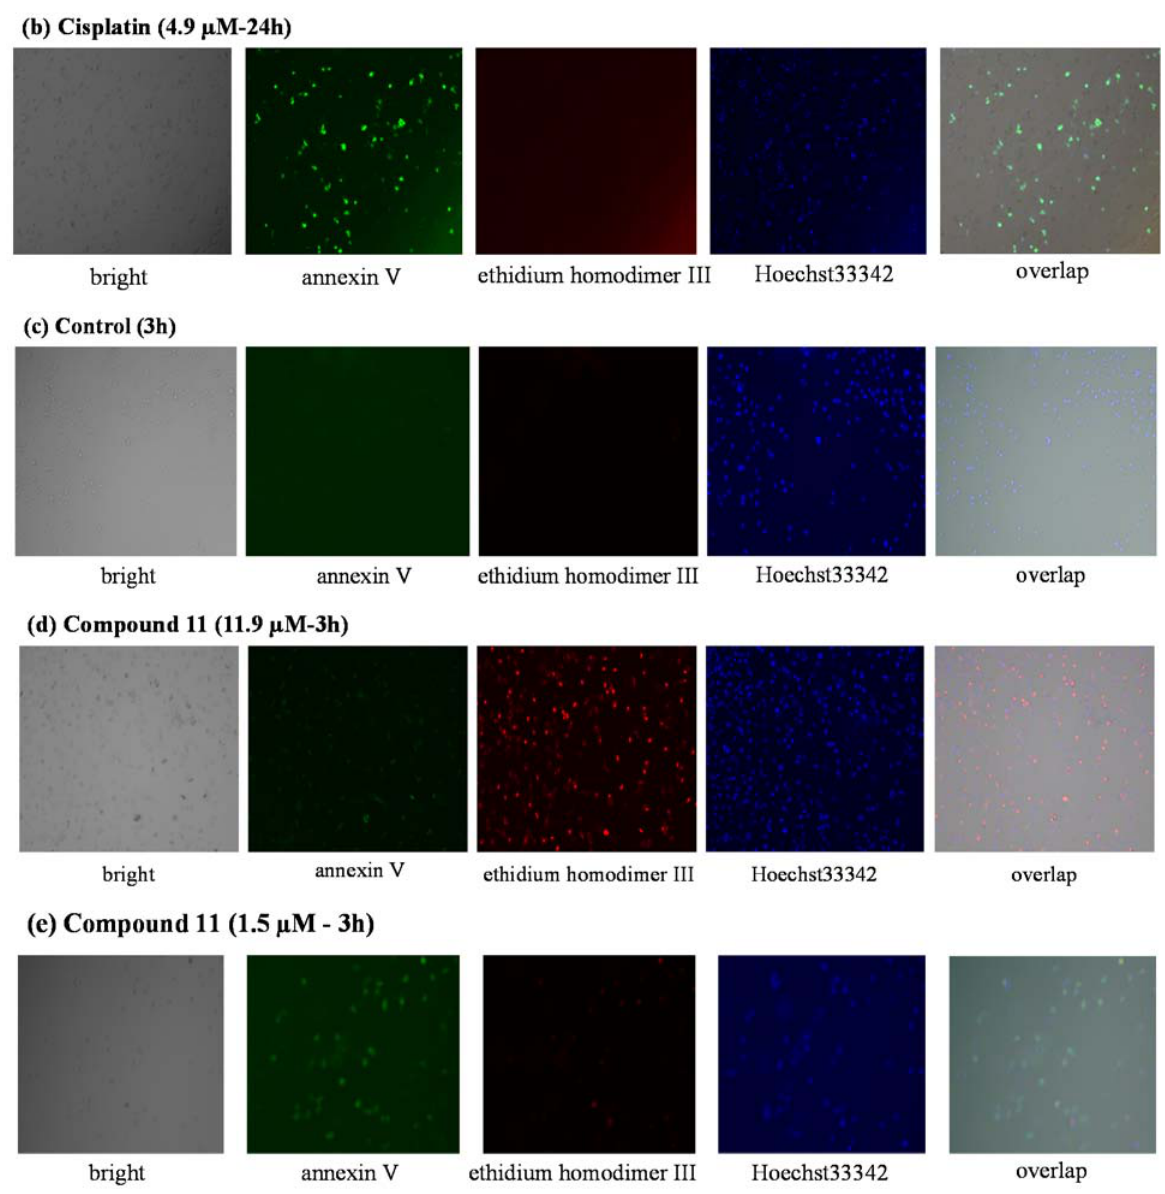
Figure 4. Cellular and nuclear morphological changes of U251 cells following exposure to IC 50 concentrations of control ( a ); cisplatin (4.9 μ M) ( b ); for 24 h and control ( c ); compound 11 (11.9 μ M) ( d ); and (1.5 μ M) ( e ) for 3